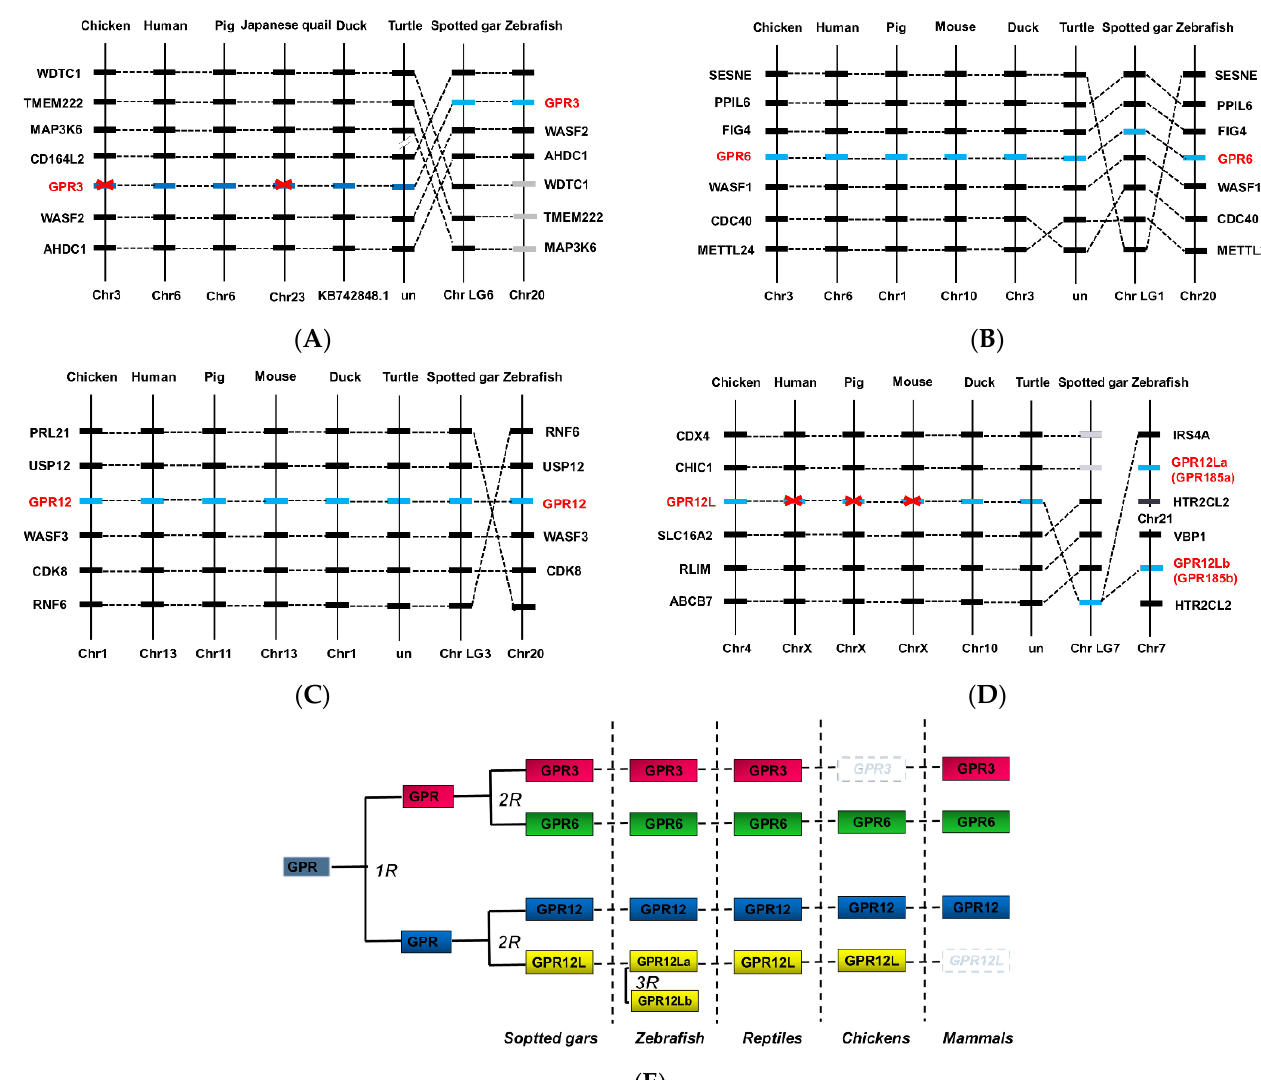
Figure 2. Synteny analysis of GPR3 , GPR6 , GPR12 , and GPR12L in chickens and other vertebrates. GPR3 ( A ), GPR6 ( B ), GPR12 ( C ), and GPR12L ( D ) are located in four syntenic regions conserved in vertebrate species including chickens, ducks, humans, pigs, turtles, spotted gars, and zebrafish. Dashed lines denote the genes of interest, while dotted lines indicate the syntenic genes identified in these species. Chr, chromosome. ( E ) Schematic diagram showing the existence of GPR3 , GPR6 , GPR12, and GPR12L in vertebrate species including spotted gars, teleosts (e.g., zebrafish), turtles, chicken, and mammals. GPR3 , GPR6 , GPR12, and GPR12L were likely duplicated from a common ancestral gene ( denoted as “GPR”), which had undergone the two rounds of genome duplication event (2R) during early vertebrate evolution. The two GPR12L genes in zebrafish likely originated from the 3rd round (3R) genome duplication event occurred in teleost lineage.